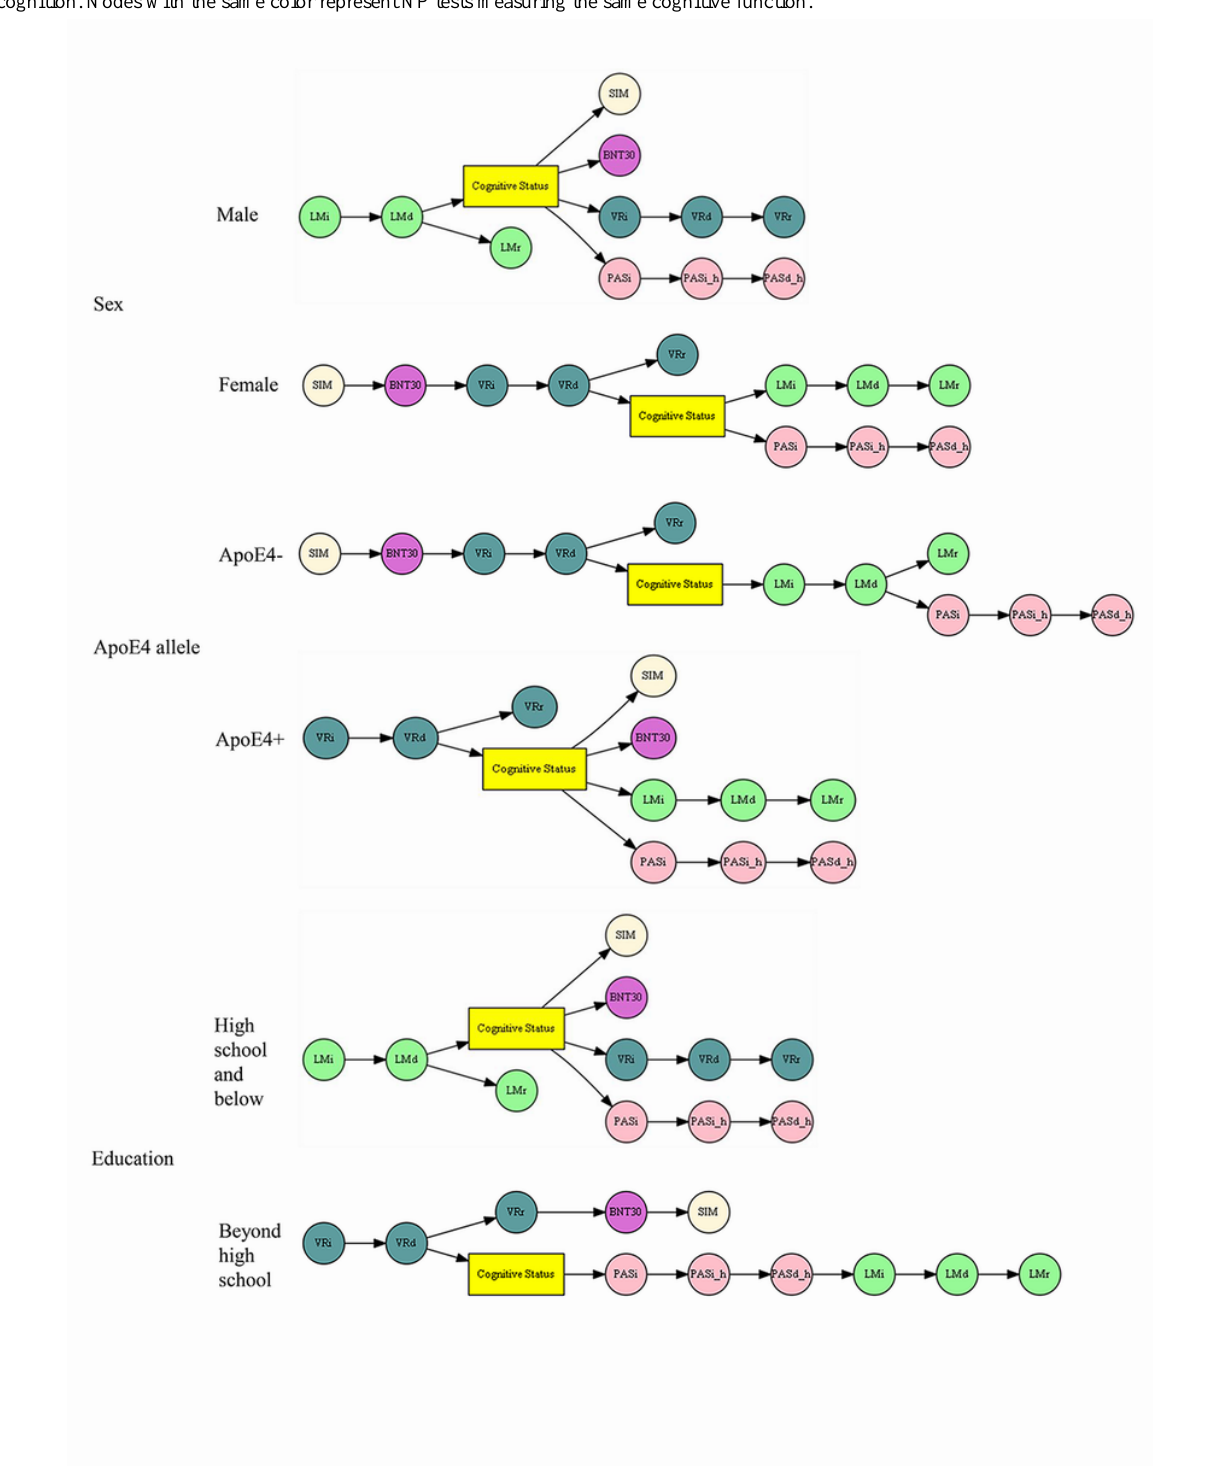
Figure 5. Hierarchical influence of neuropsychological tests and cognitive status in subpopulations. BNT30: Boston Naming Test 30 item Even